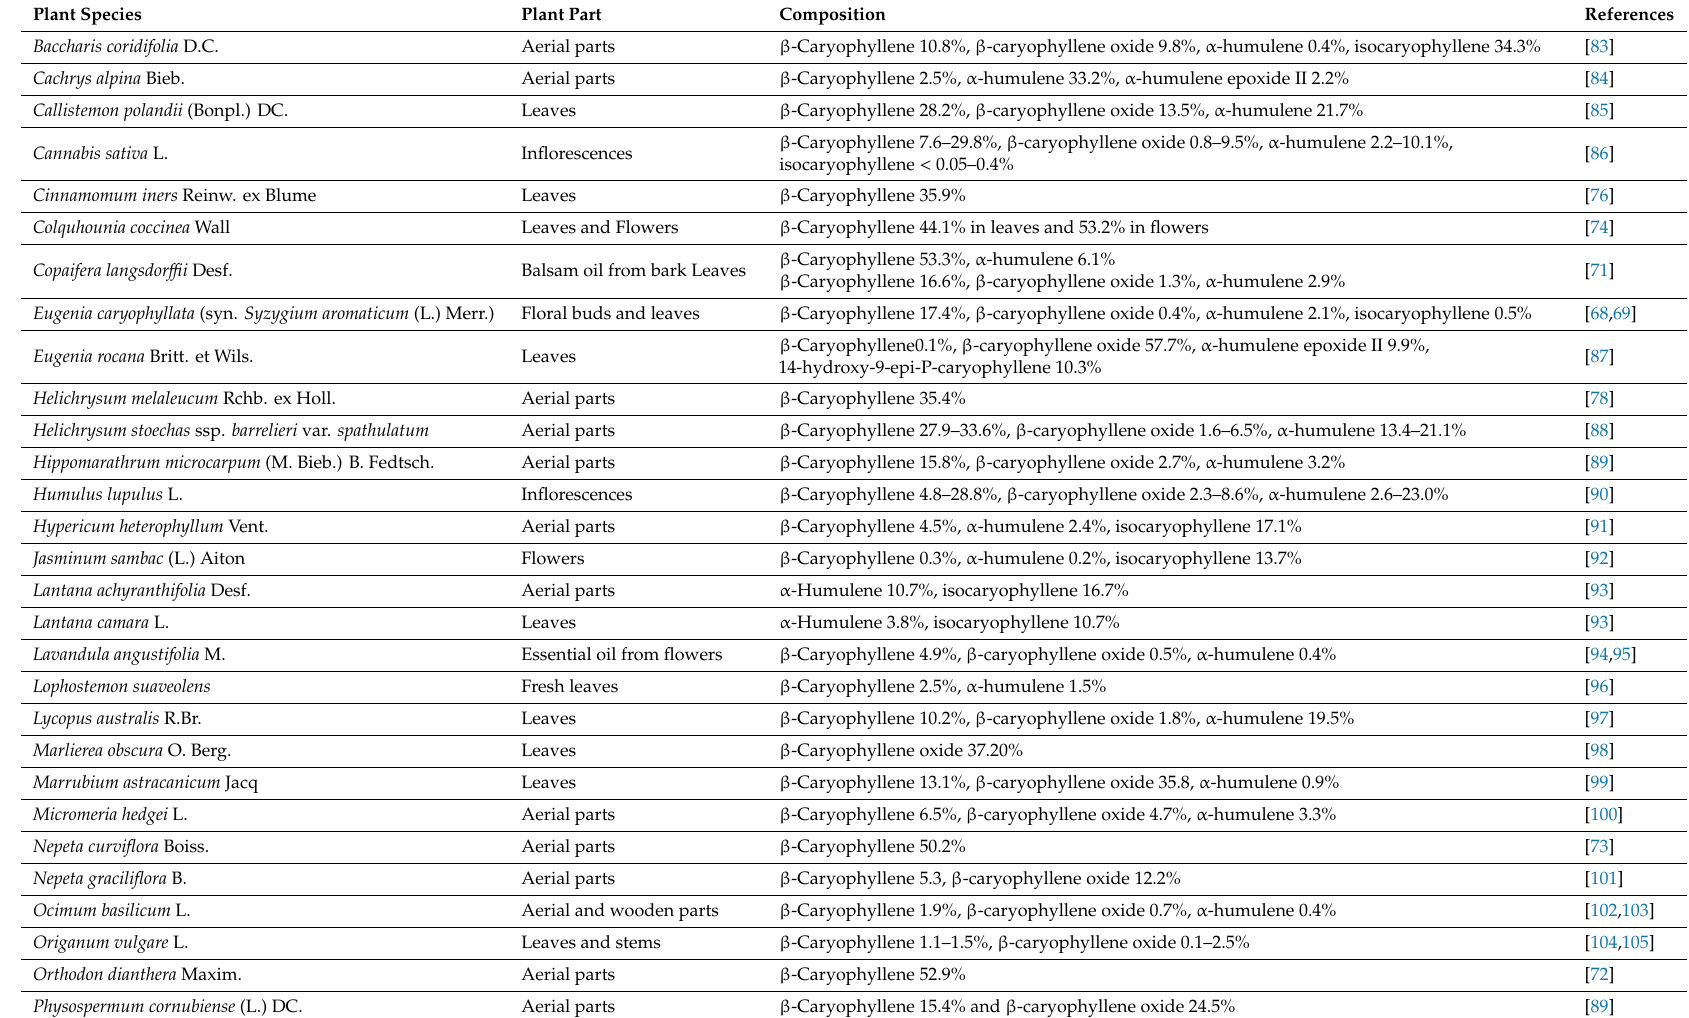
Table 2. Co-occurrence of caryophyllane sesquiterpenes in plant essential